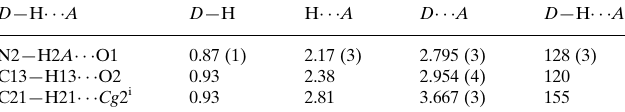
Hydrogen-bond geometry (A˚ , (cid:2) ). Cg 2 is the centroid of the C1–C6